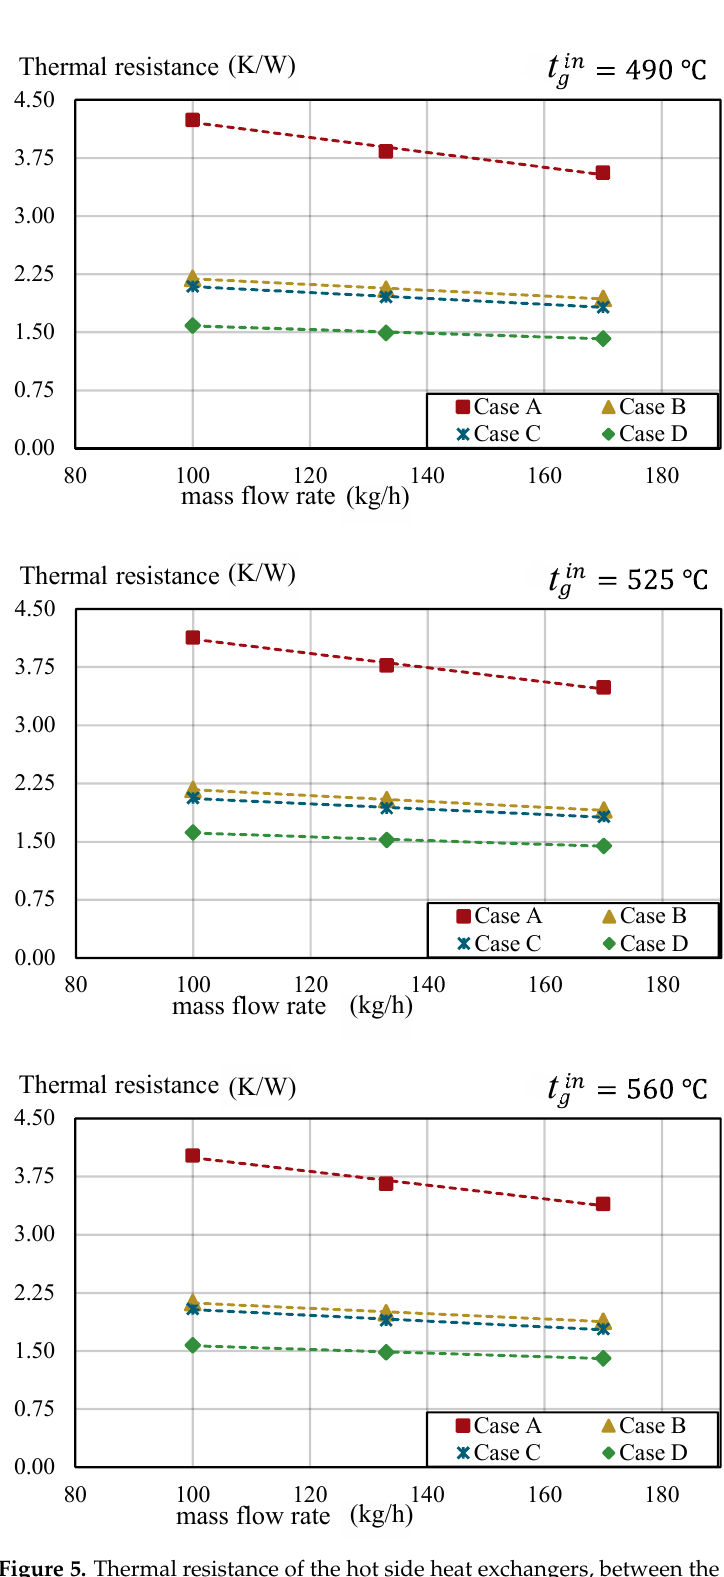
Figure 5. Thermal resistance of the hot side heat exchangers, between the exhaust gases and the hot face of the thermoelectric